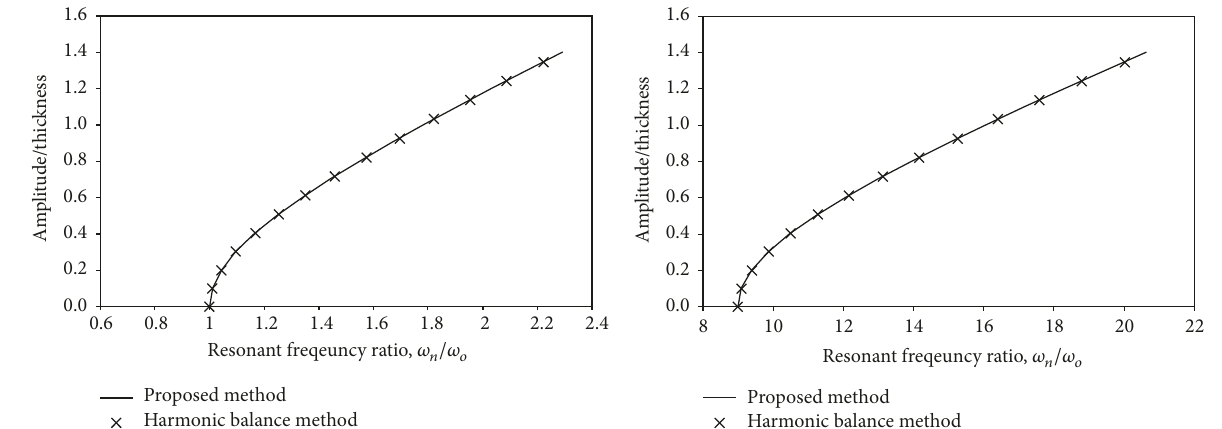
methodResonant freqeuncy ratio, 휔 n /휔 o Proposed method Harmonic balance